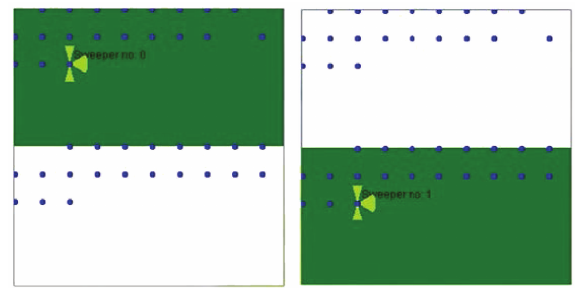
Figure 2: Two sensing agents in fully coordinated